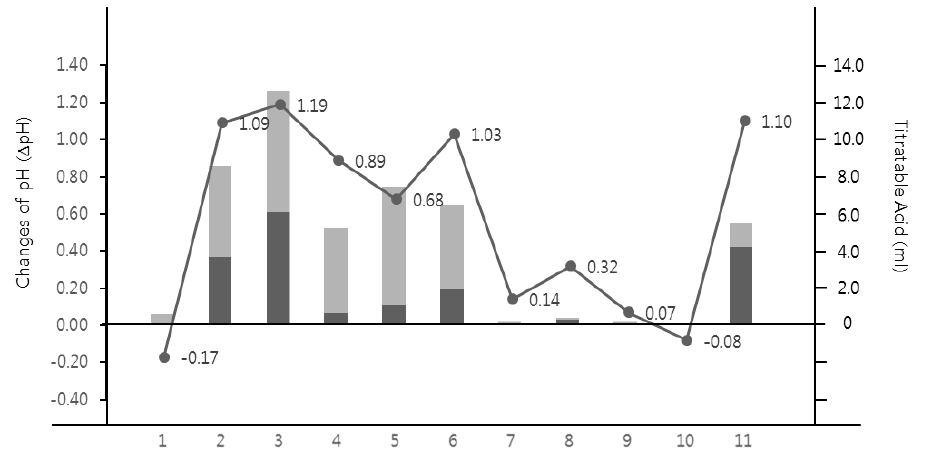
Figure 1. Test results for the erosive potential of fever reducers. The line indicates changes in pH of the CaPO 4 solution after the addition of the experimental groups. The bar graph indicates the NaOH volume to obtain pH 5.5 and pH 7.0, respectively. The sample names were represented as